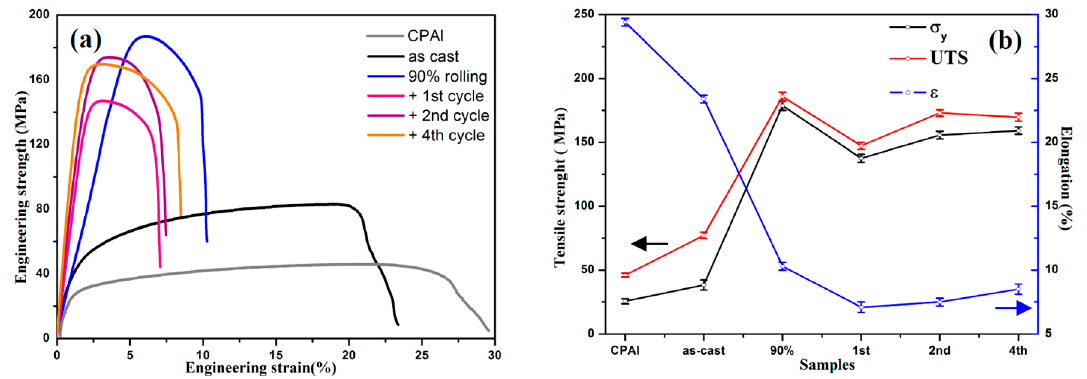
Figure 8. Tensile properties of the Al-TiB 2 /TiC composites. ( a ) Typical engineering stress-strain curves of the composites and CPAl; ( b ) Variations of σ y , UTS and elongation of the composites as a function of different deformation treatments.